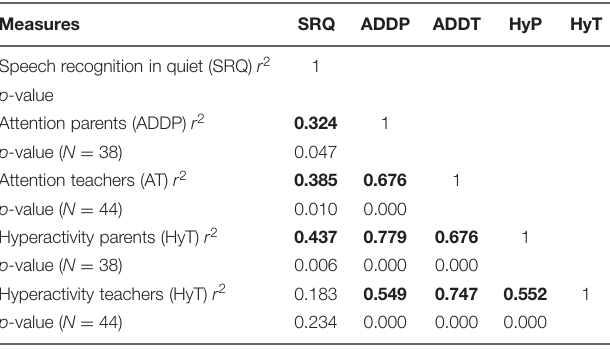
TABLE 2 | Bivariate correlation between speech recognition threshold, attention, and